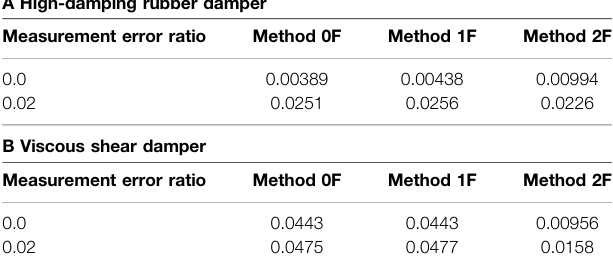
TABLE 3 | RMSER of tension